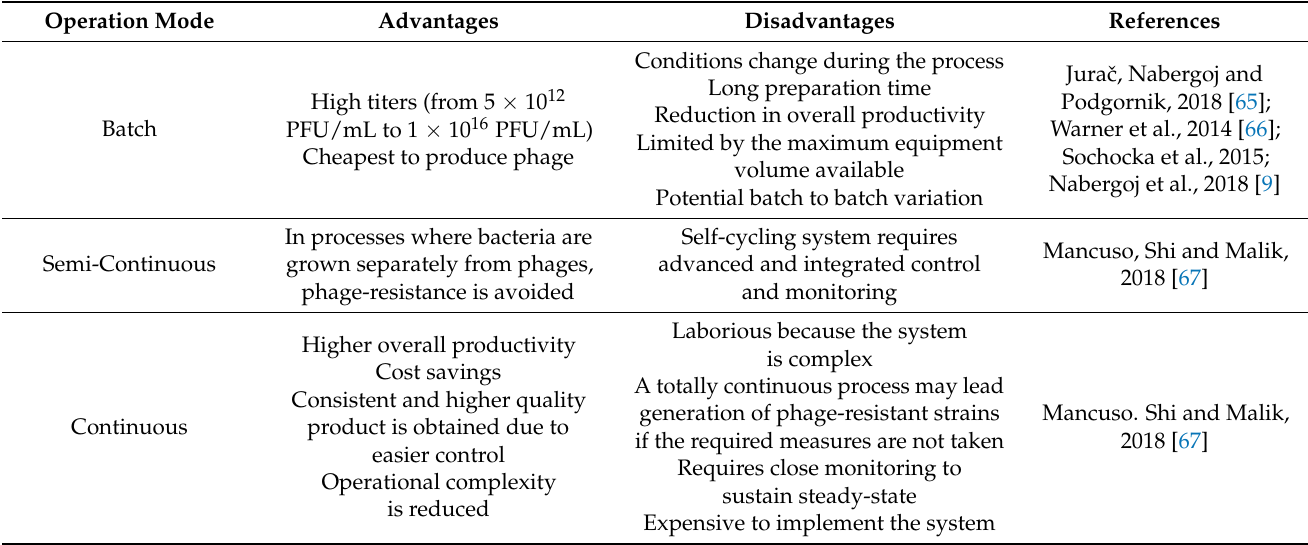
Table 1. Overview of phage production